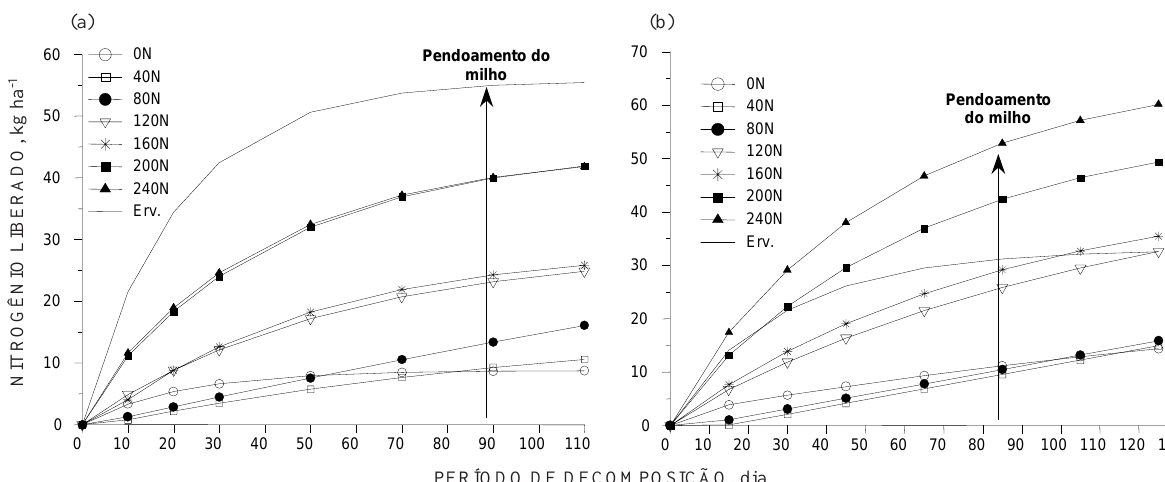
Figura 4. Estimativa da mineralização do N da fitomassa de aveia preta e de ervilhaca no sistema plantio direto, nos anos de 1998 (a) e de 1999 (b).